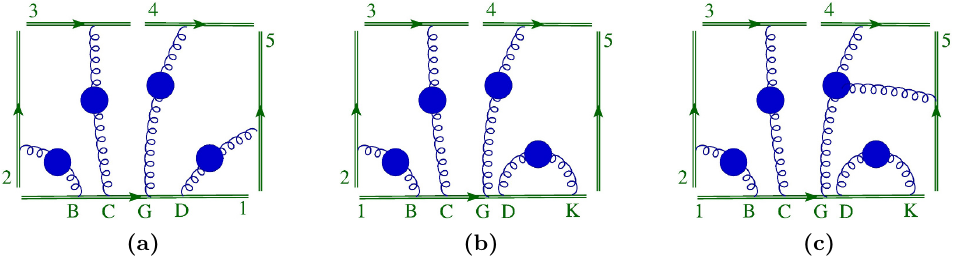
Figure 8. Cwebs with same reducible diagrams.